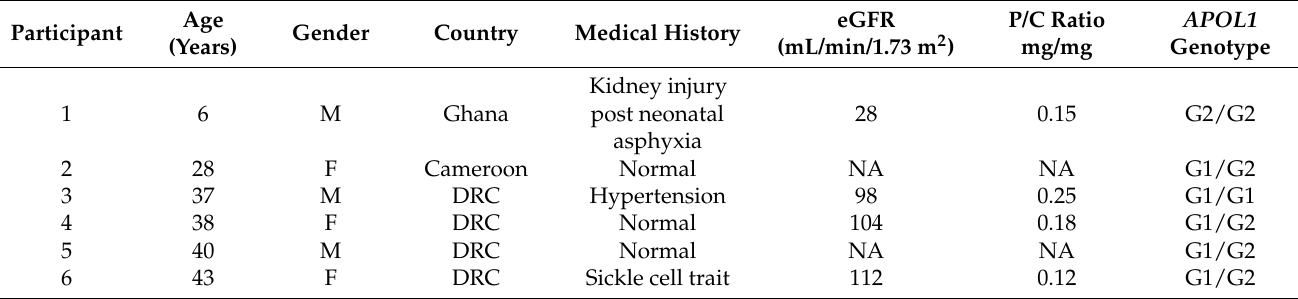
Table 2. Baseline characteristics of participants carrying APOL1